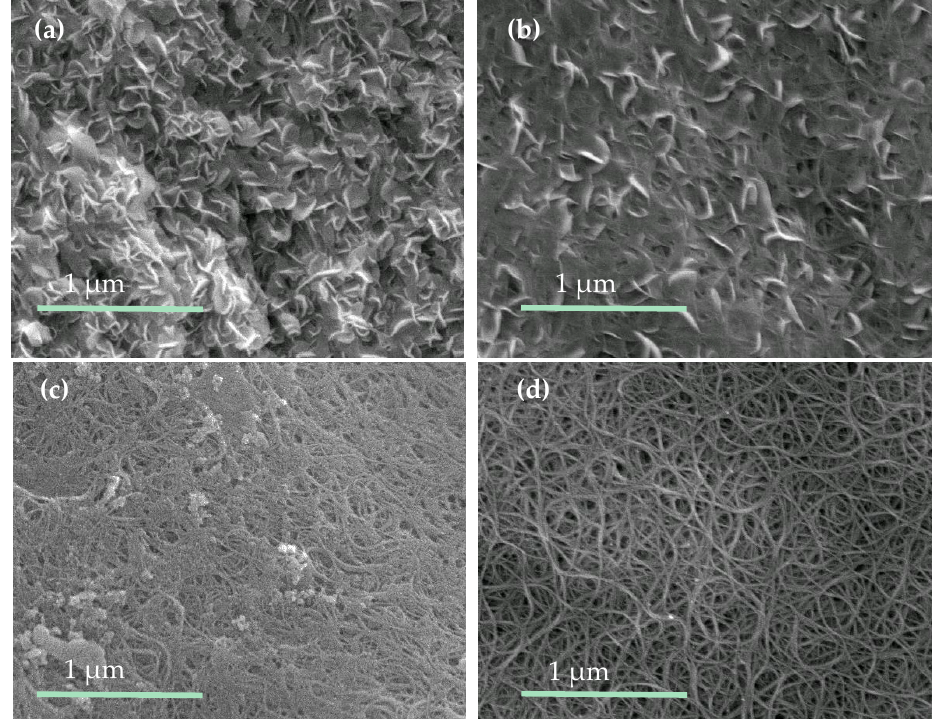
Figure 2. SEM surface morphology of MoS 2 @CNT composite: ( a ) pristine sample and ( b – d ) treated with 10% wt. HNO 3 for 2 h , 8 h , and 12 h .